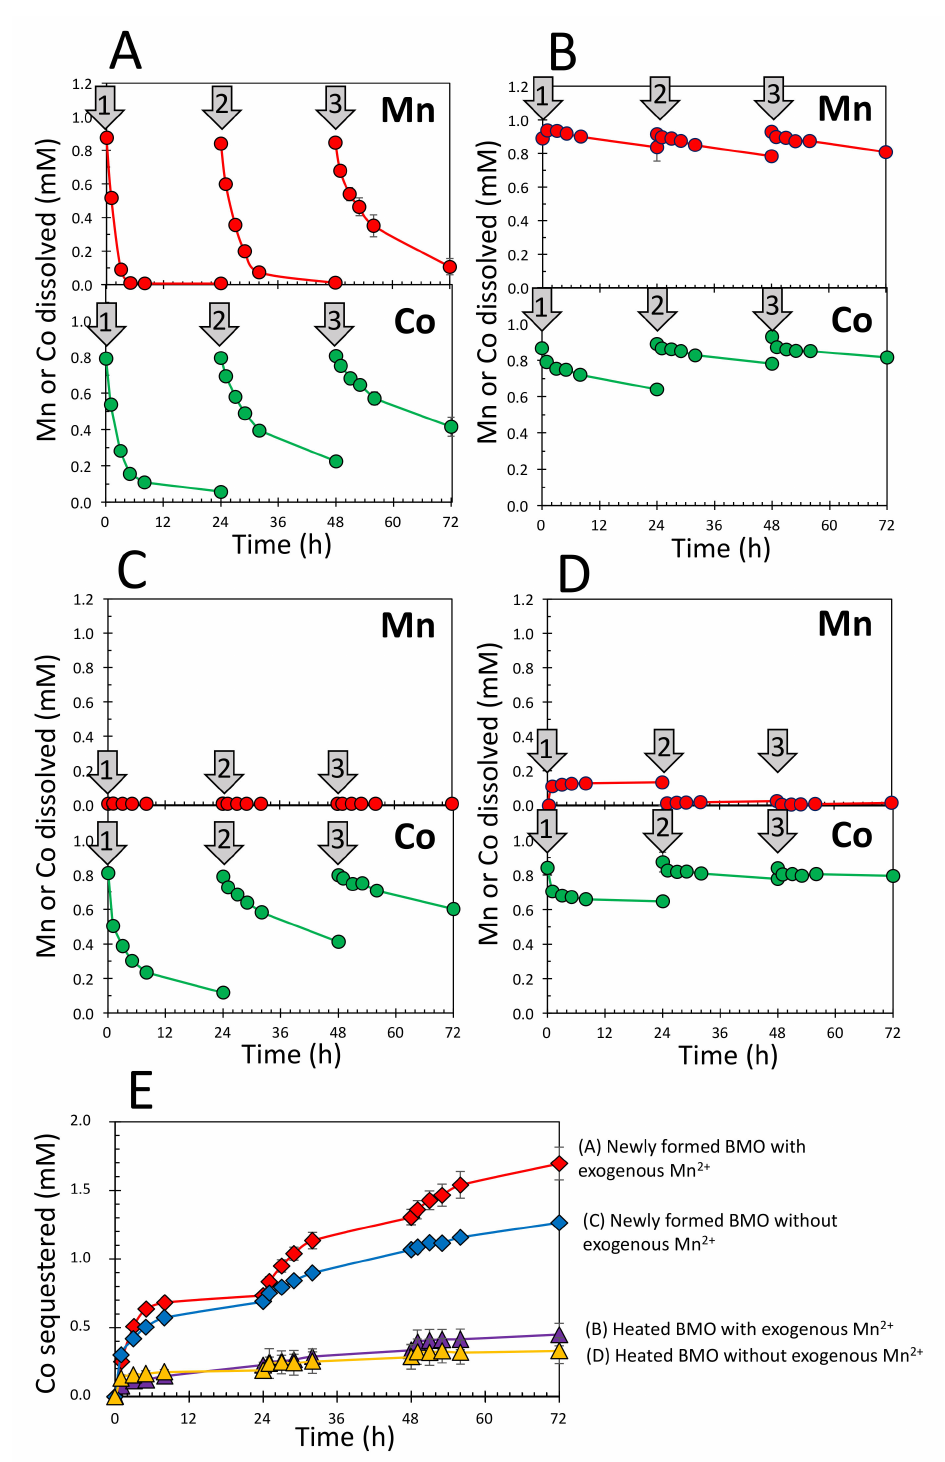
Figure 1. Repeated treatment experiments of newly formed ( A , C ) and heated ( B , D ) biogenic man- ganese oxides (BMOs; 1 mM as Mn) under aerobic conditions at pH 7.0 (100 mM HEPES buffer) in 0.8 mM Co 2+ solutions with ( A , B ) and without ( C , D ) 0.8 mM exogenous Mn 2+ . Cumulative concentrations of sequestered Co were plotted as a function of treatment time ( E ). Bathing solutions were renewed every 24 h. Data are the mean ± standard deviation ( n = 3 or